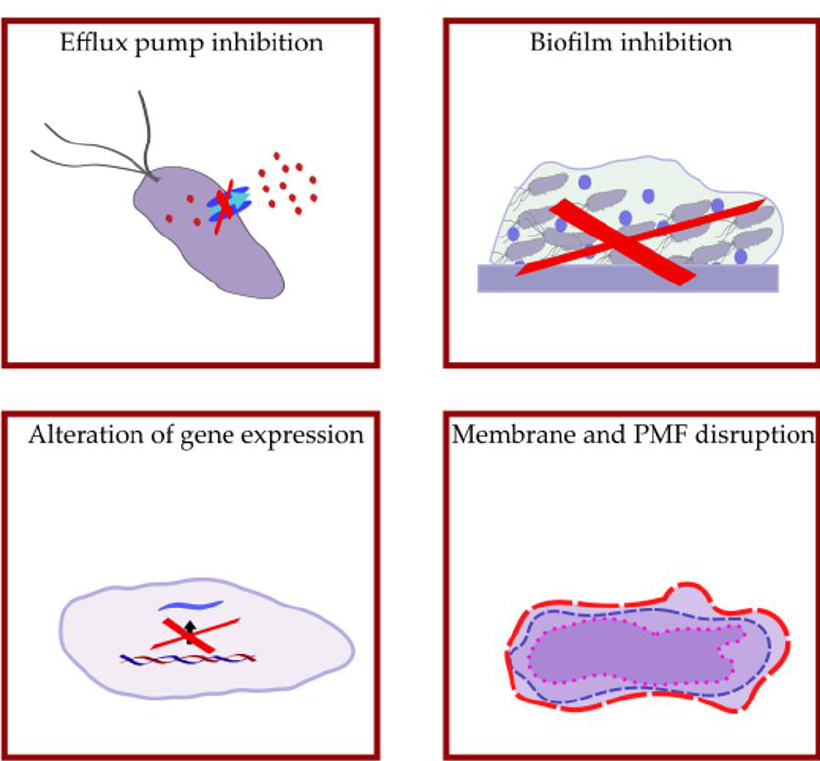
Figure 4. Antibacterial activity of selective serotonin reuptake inhibitors (SSRIs), tricyclic antidepressants (TCAs), and phenothiazine-type antipsychotics. PMF: proton motive force.